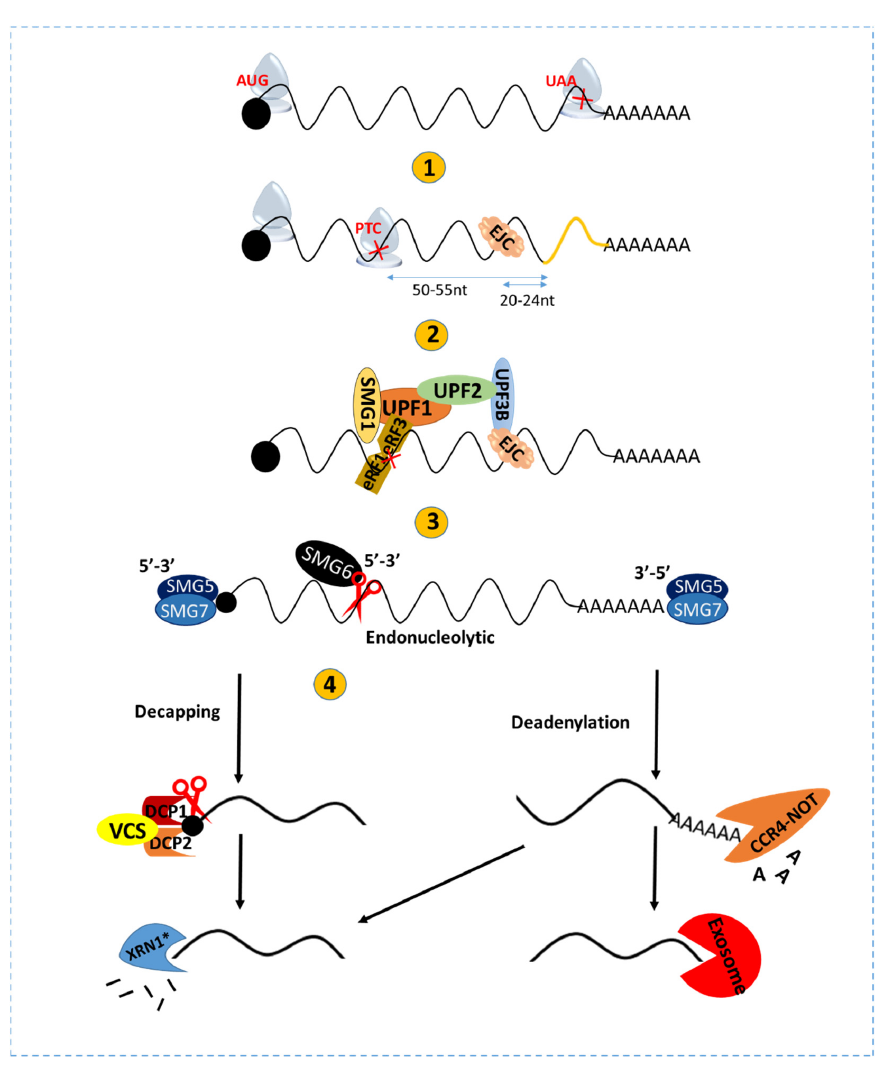
Figure 1. PTC-based NMD activation and RNA decay. NMD is activated when PTC is located >50-55 nucleotides upstream of the exon–exon junction. While pre-mRNA is spliced to mature mRNA, EJC deposits 20–24 nucleotides upstream of the exon–exon junction and cannot be removed by translating ribosomes. Subsequent deposition of eRF1 and eRF2 dissociates ribosome, thereby binding eRF3 and UPF1. SMG1-mediated phosphorylation of UPF1 initiates a conformational change of UPF1 to recruit UPF2 and UPF3, which precedes the reaction further. SMG1, UPF1, eRF1, and eRF3 together form the SURF complex. Afterward, UPF2 connects EJC and UPF1 via UPF3, which recruits relevant decay factors. Target transcripts can be degraded by two major cellular cleavage pathways, endo-nucleolytic and exo-nucleolytic. SMG6 is an endonuclease recruited by phosphorylated UPF1 at the PTC, cleaving the NMD substrate. SMG5/7 promote the exo-nucleolytic pathway by recruiting decapping complex DCP1a/DCP2 at the 5 (cid:48) end and recruiting deadenylation complex CCR4-NOT at the 3 (cid:48) end. Nascent decapped transcripts were further digested in a 5 (cid:48) → 3 (cid:48) manner via XRN1*. Deadenylated RNA transcripts can be